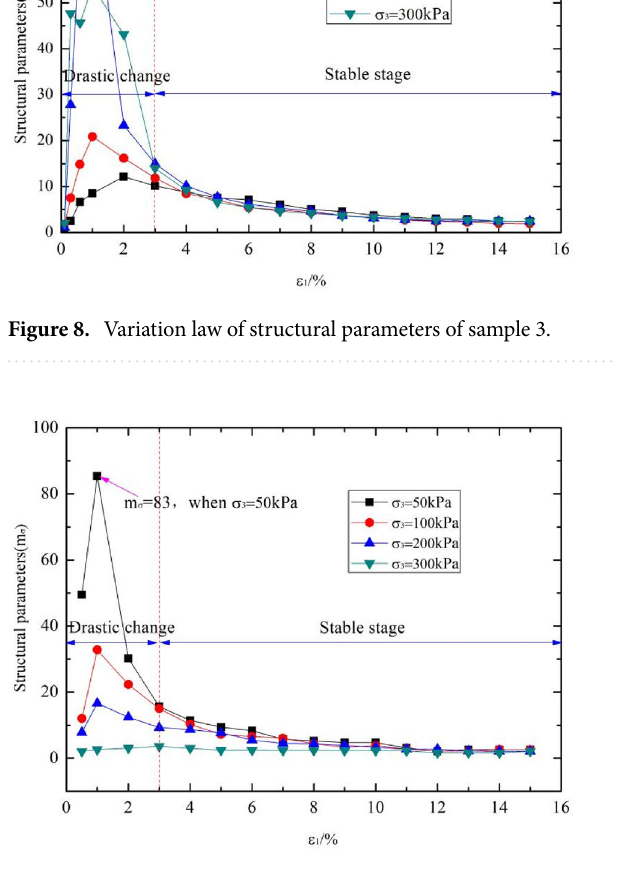
Figure 9. Variation law of structural parameters of undisturbed